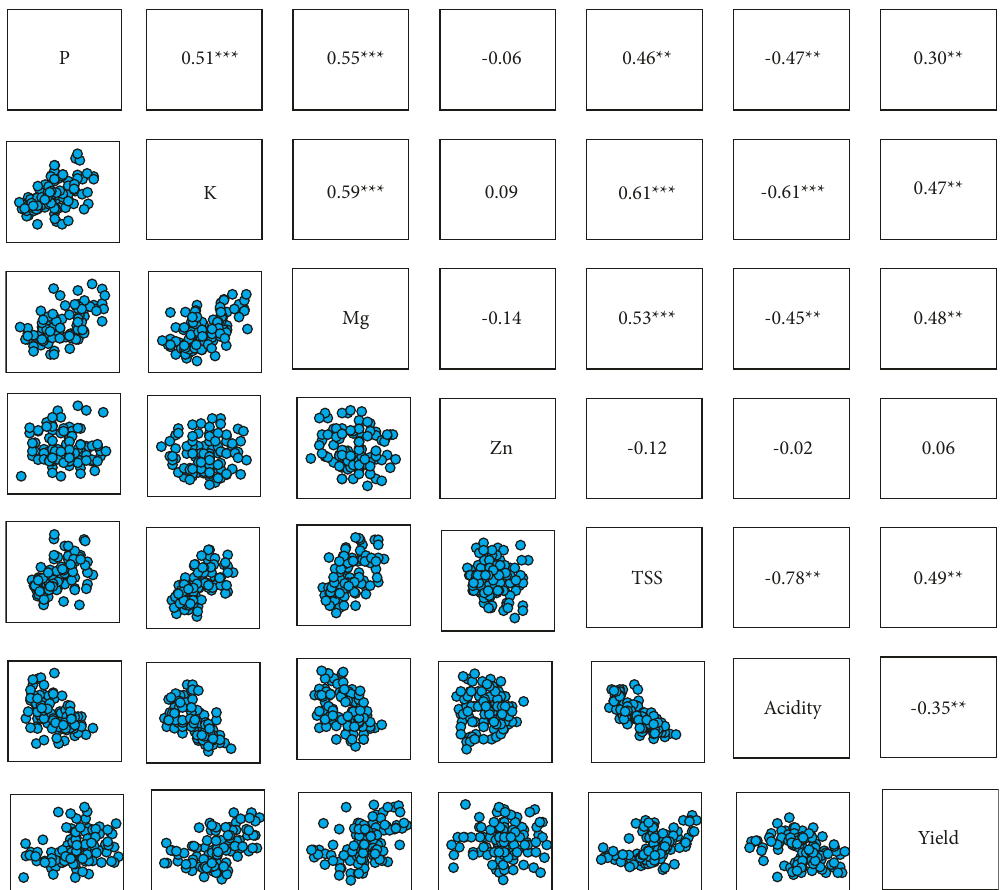
Figure 3: Correlation coefficient matrix of fruit nutrients, fruit yield, and fruit